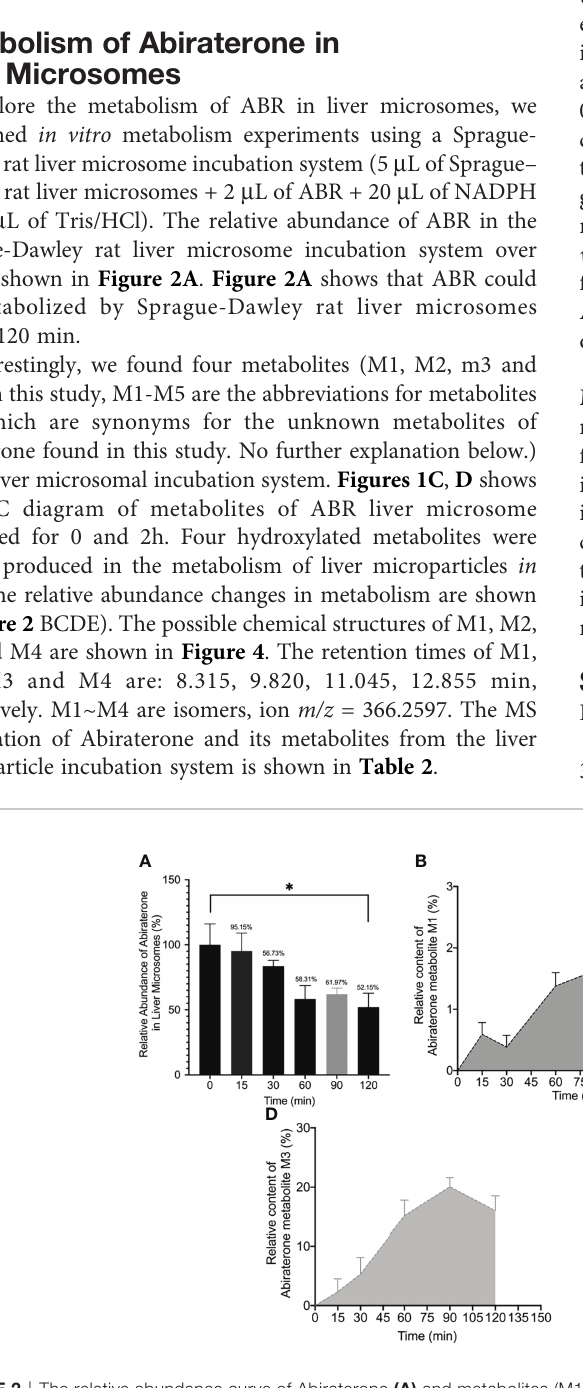
FIGURE 2 | The relative abundance curve of Abiraterone (A) and metabolites (M1, M2, M3, M4) (B – E) incubated with rat liver microsomes at different time points (0 min, 15 min, 60 min, 90 min and 120 min) (*). *P <